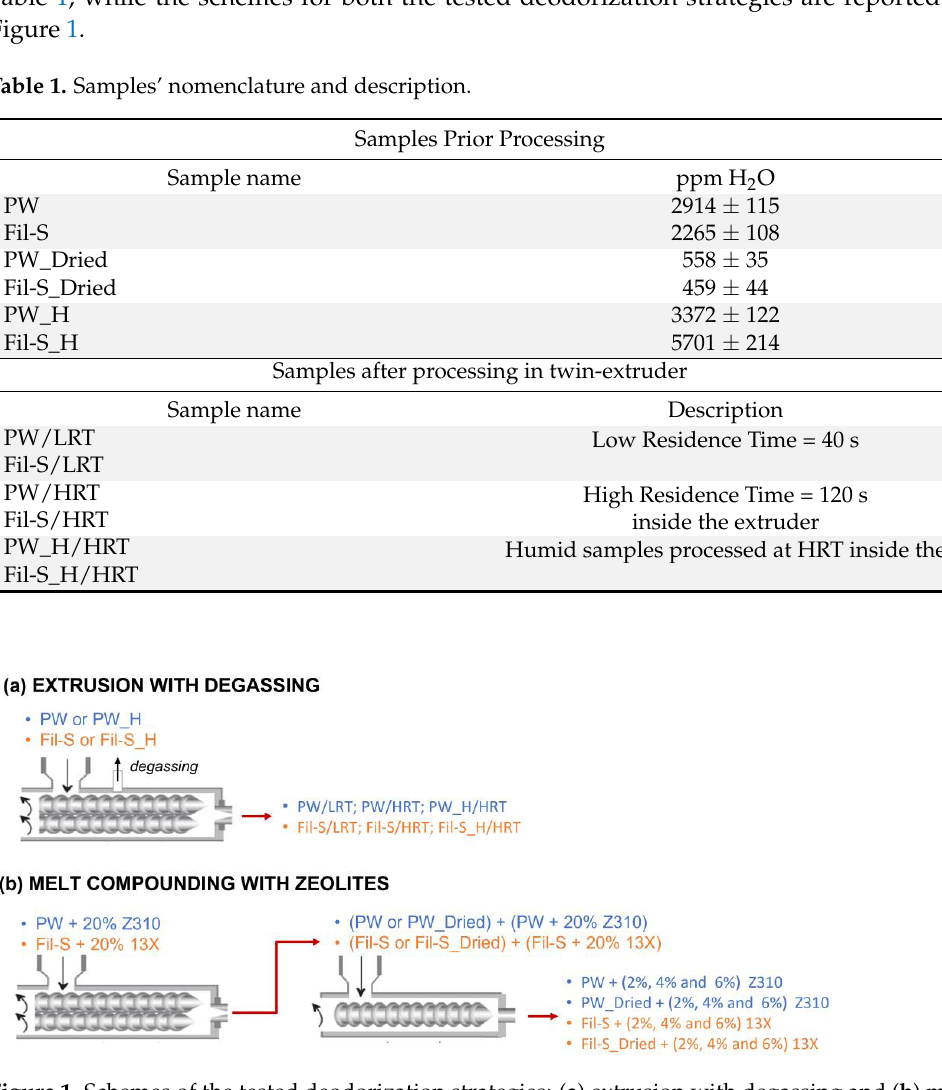
Figure 1. Schemes of the tested deodorization strategies: ( a ) extrusion with degassing and ( b ) melt compounding with zeolites.